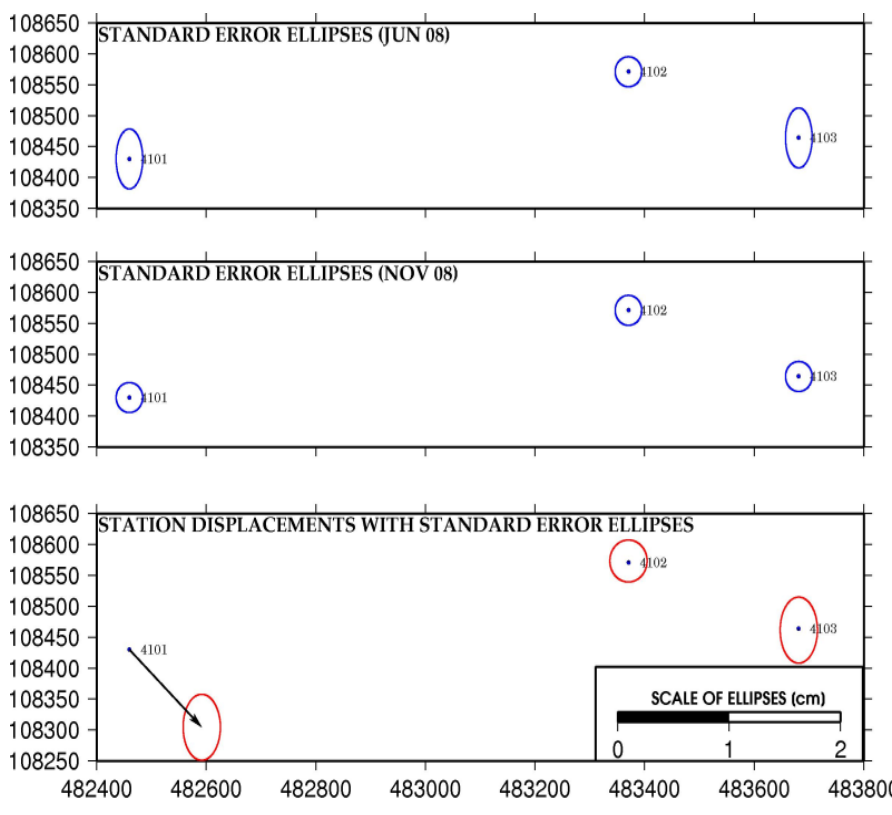
Figure 9. Graphical results of reference pillar